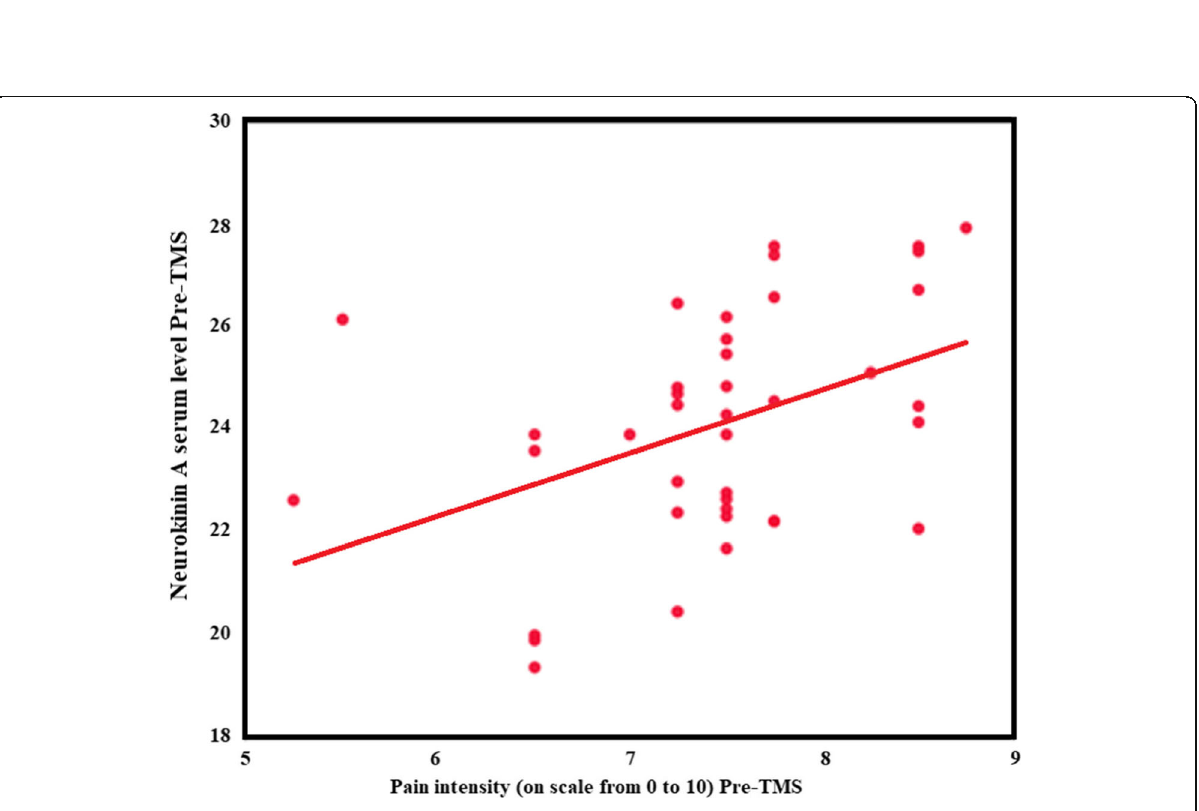
Fig. 2 Correlation between neurokinin A serum level and pain intensity